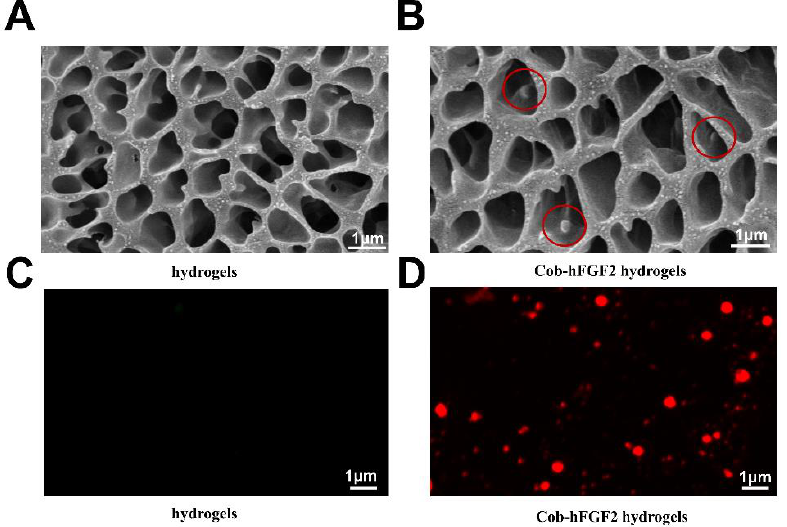
Figure 1. Characterization of CLD-hFGF2 hydrogels. Microstructure of the blank hydrogels ( A ) and CLD-hFGF2 hydrogels ( B ) observed using Cryo-SEM (red circle represents CLD-hFGF2). Fluorescence image of blank hydrogels ( C ) and CLD-hFGF2 hydrogels ( D ) (scale bar = 1 μ m, n = 3).